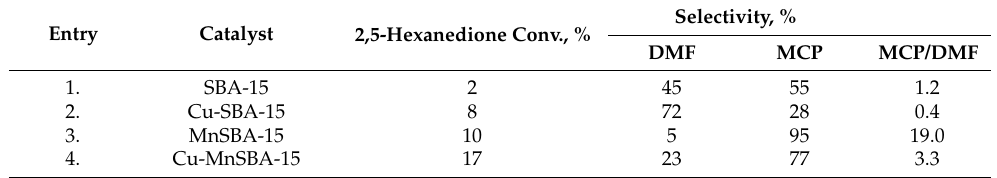
Table 5. Results of 2,5-hexanedione cyclization and dehydration at 623